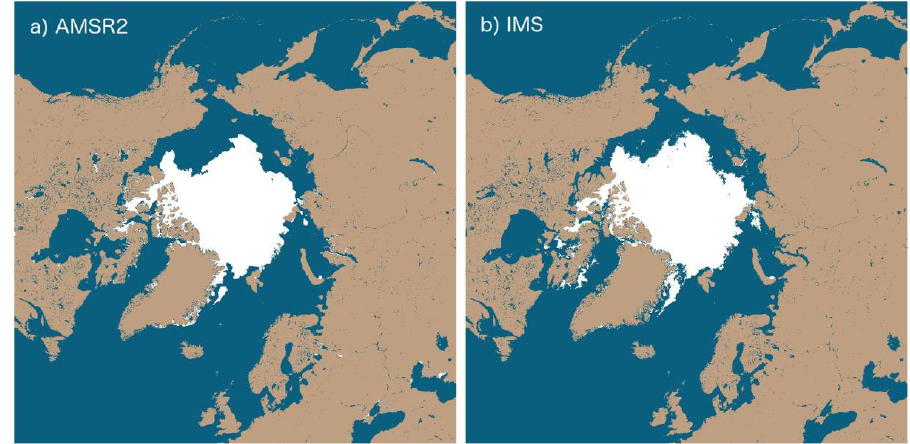
Figure 1. Ice cover from AMSR2 ( a ) and IMS ( b ) on 15 August 2017.